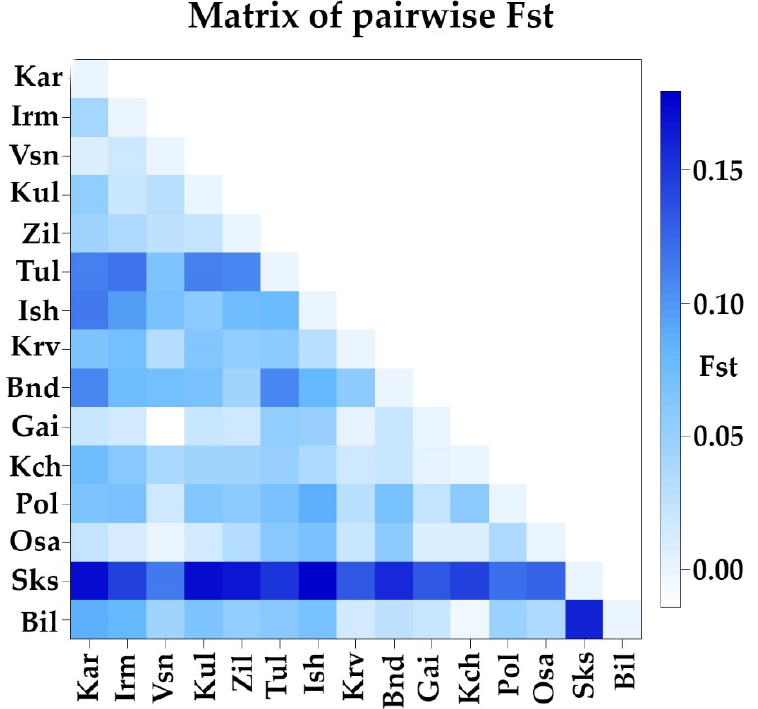
Figure 1. Visualization of the matrix of pairwise F ST values. Color indicates the degree of differentiation (the darker, the stronger the differentiation).